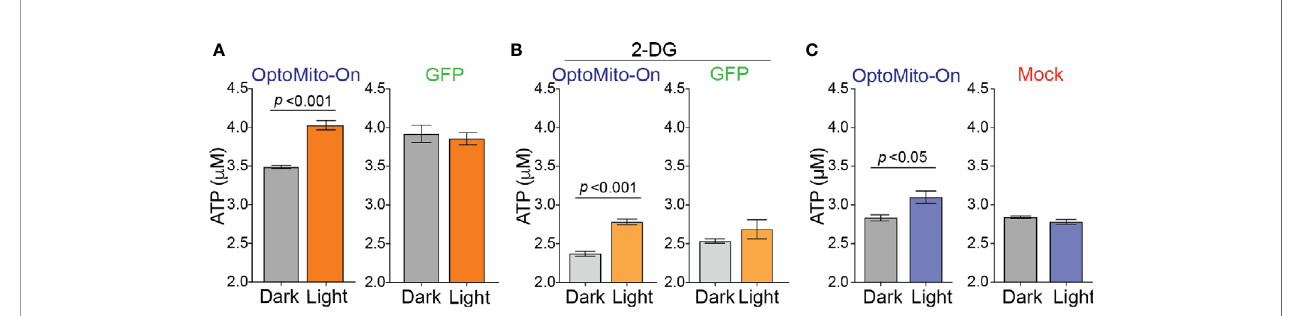
FIGURE 4 | Activation of OptoMito-On increases ATP production. (A) HEK293T cells expressing OptoMito-On or GFP were illuminated with 590 nm light for 2 hours, followed by a luciferase-based ATP assay. (B) Same set-up as in (A) , except HEK293T cells were treated with 10 mM 2-DG for 2 hours prior to illumination. (C) Activated CD8 + T cells were sorted based on GFP expression. GFP negative cells were used as the mock control. CD8 + T cells received 590 nm light for 30 minutes, followed by a luciferase-based ATP assay. All data shown as mean ± SEM and analyzed by an unpaired t-test (n =